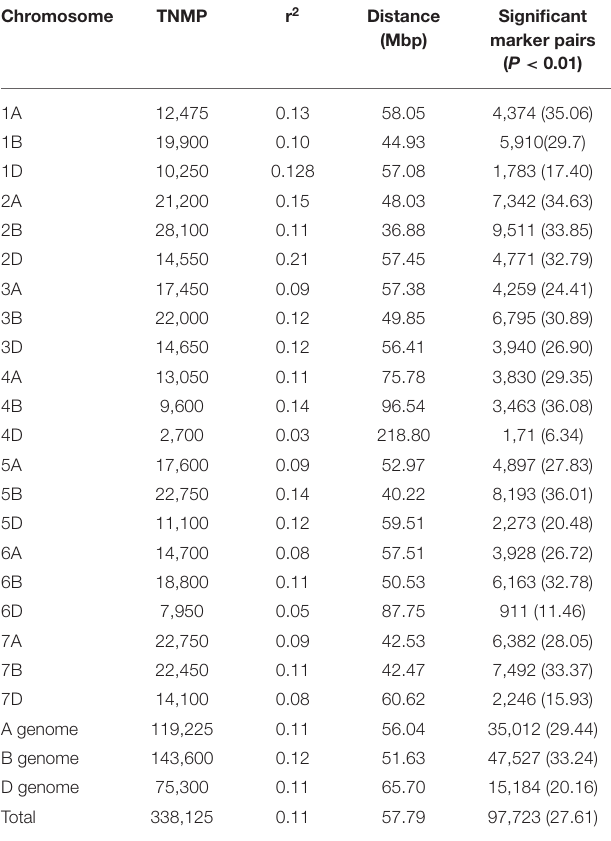
TABLE 7 | Summary of linkage disequilibrium analyses among marker pairs and the number of significant marker pairs per chromosome and genome. Chromosome TNMP r 2 Distance